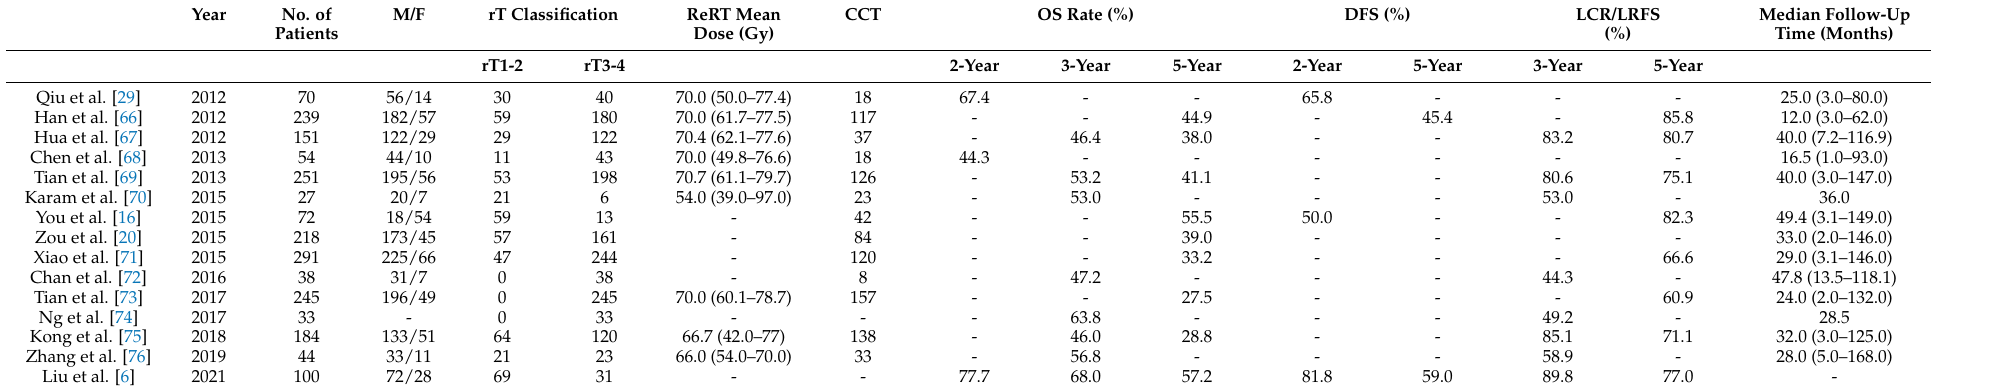
Table 1. Characteristics of the literature on IMRT for recurrent NPC in the last 10